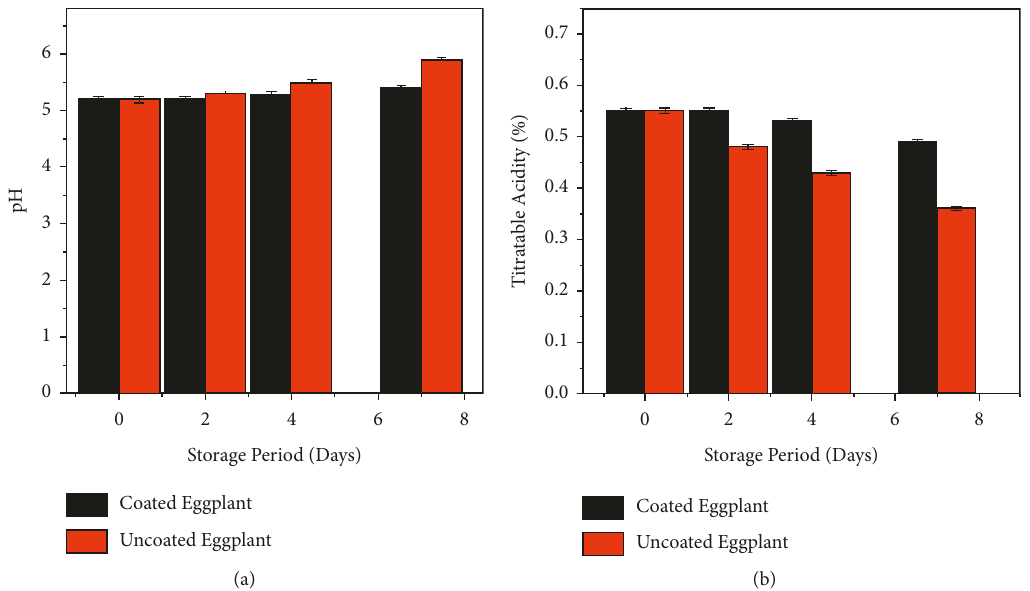
Figure 5: Effect of active coating on the pH (a) and titratable acidity (b) of solanum melongena along with storage